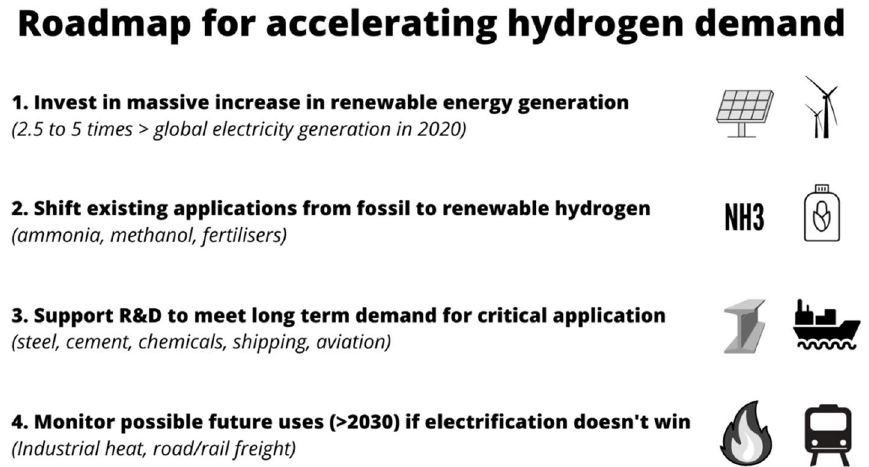
Fig. 5 Proposed roadmap for accelerating global hydrogen demand. Author